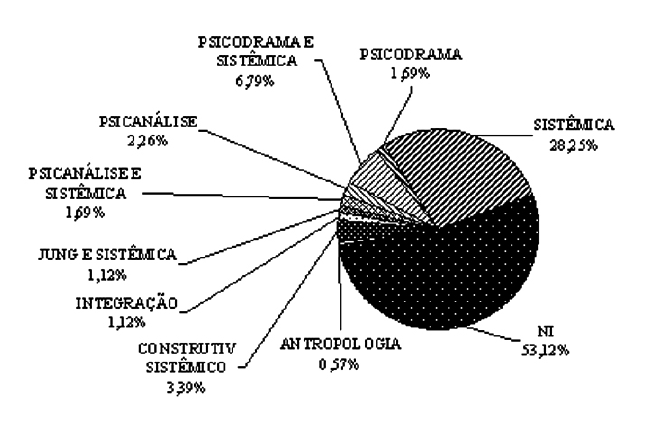
Figura 6 . Referências teóricas apresentadas no Caderno de Resumos do II Congresso Brasileiro de Terapia de Família.